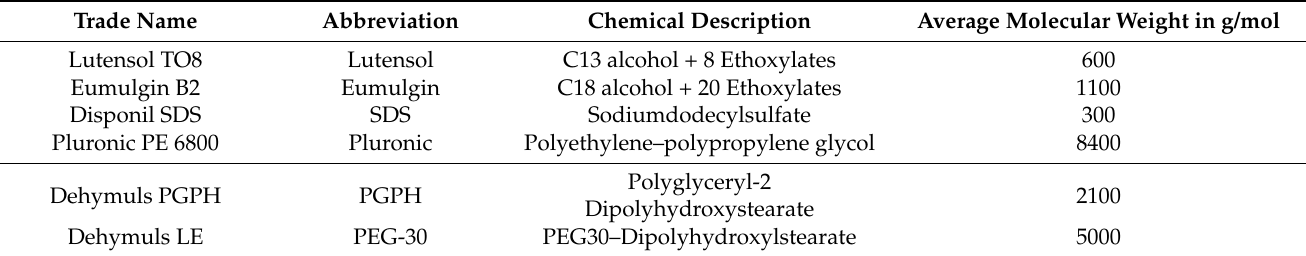
Table 1. List and chemical description of surfactants used in this